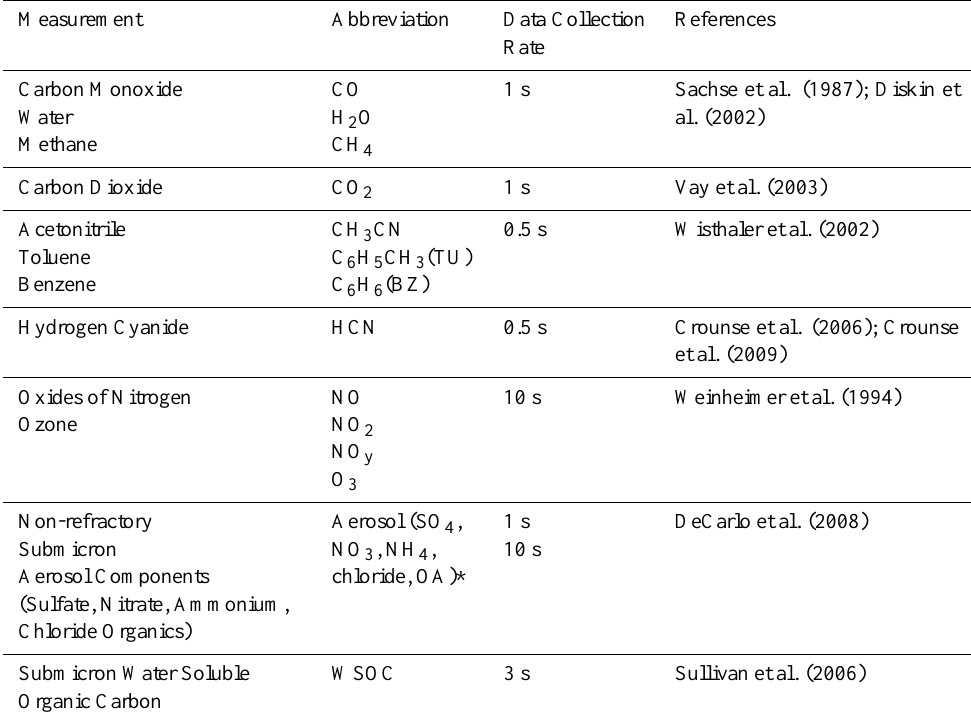
Table 1. Measurements from the NASA DC-8 Aircraft Used in the Analyses Presented in This Paper.